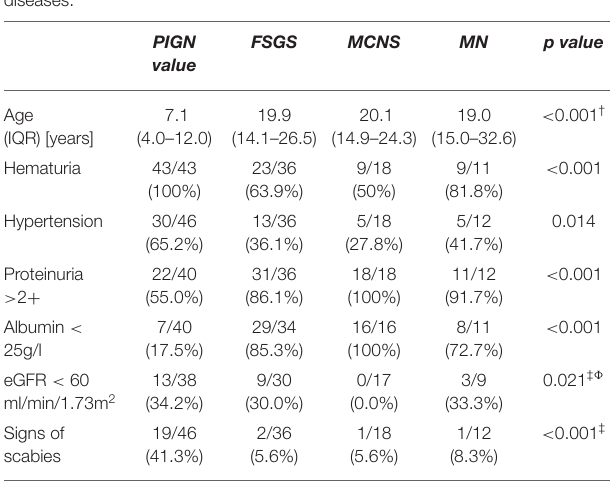
TABLE 1 | Comparison of clinical and laboratory data between main histological